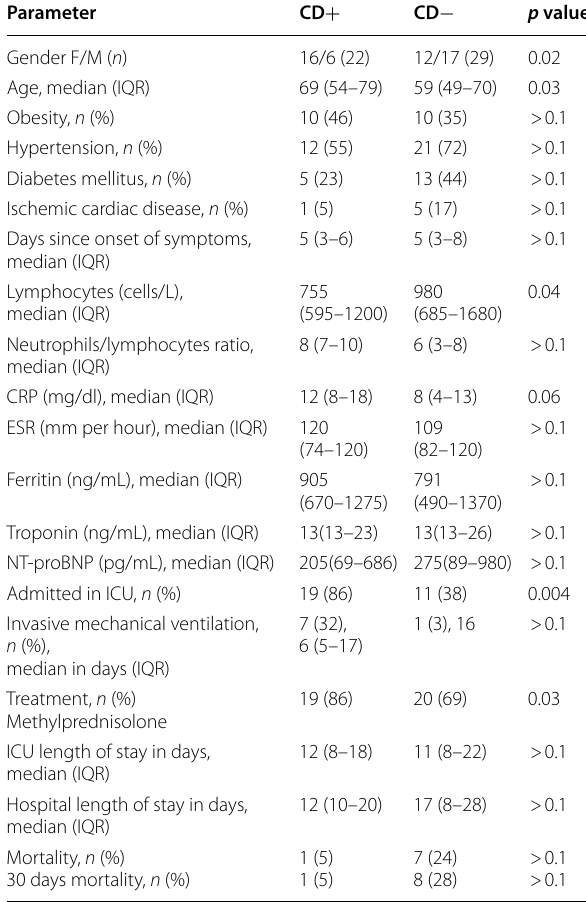
Table 1 Demographic, clinical and laboratory characteristics